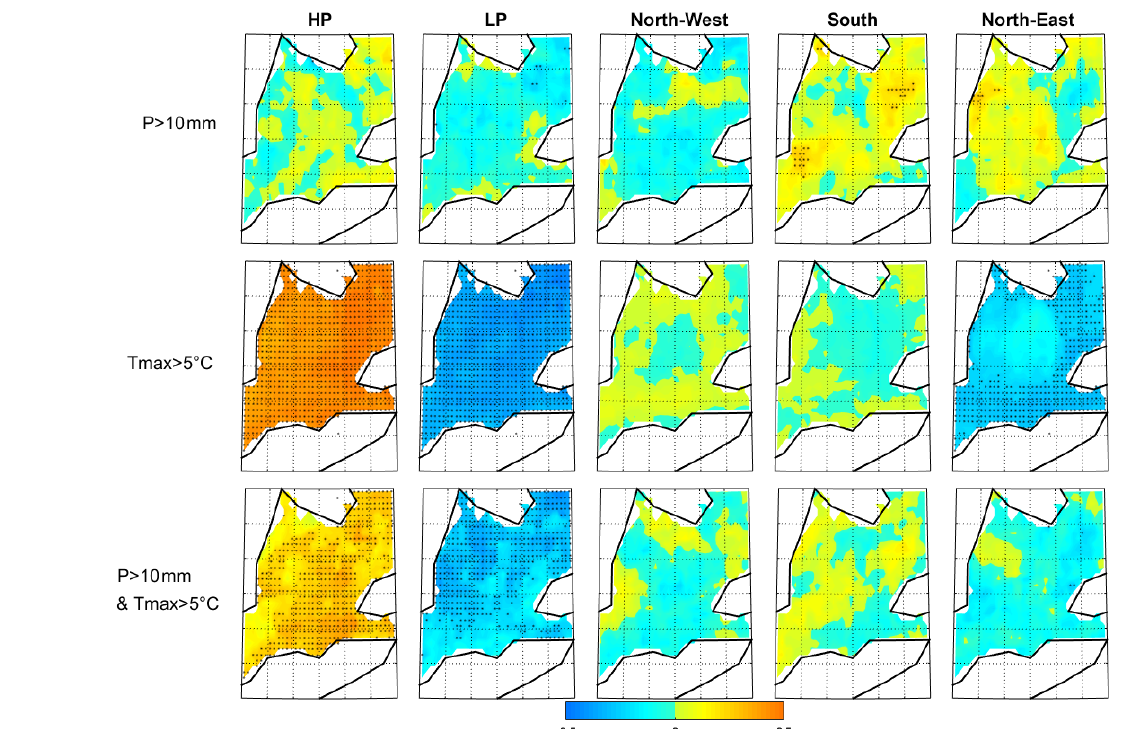
Figure 11. DJF inter-member correlations between change in occurrence of weather regimes and change in number of events between 1961– 1990 and 2026–2055. Black points indicate a correlation significant at 95% according to the Pearson correlation